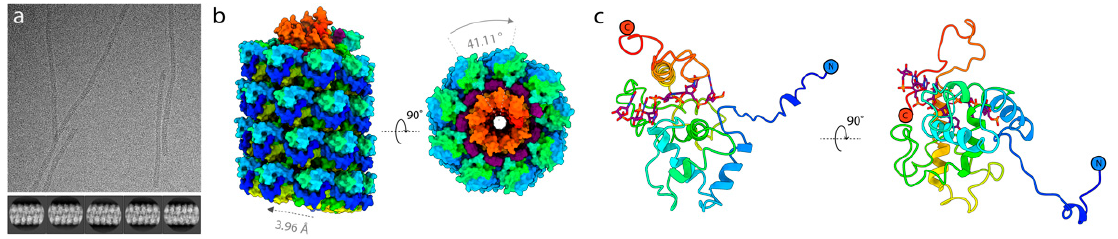
Figure 5. The cryo-EM structure of AltMV VLP. ( a ) Top: A representative micrograph of AltMV filaments in vitreous ice (magnification 75,000 × ) and bottom: 2d class averages of AltMV particle segments. ( b ) The structure of AltMV shown in surface representation with the coat protein colored from N-terminus (blue) to C-terminus (red). RNA is colored purple. Labels denote the determined helical parameters used in 3D refinement. ( c ) The AltMV coat protein atomic model shown in cartoon representation.